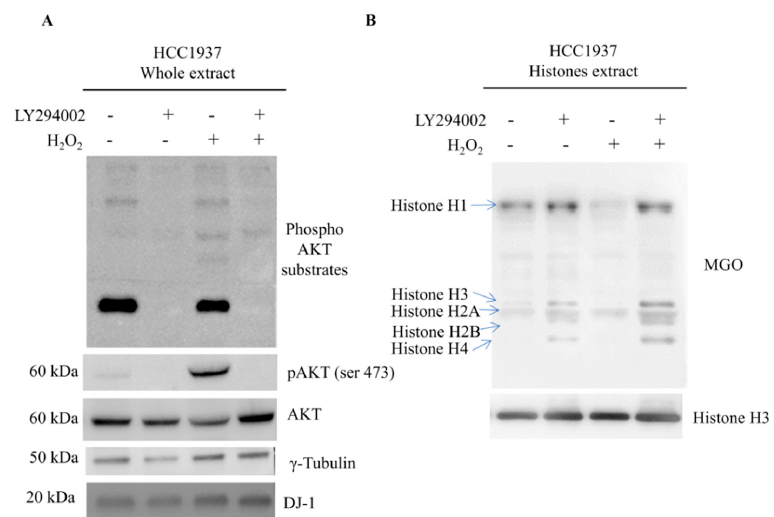
Figure 8. Western blot analysis relative to the expression of Akt activation and AGEs formations in HCC1937 breast cancer cells ( A ) Western blot analysis on whole extract from HCC1937. Levels of Phospho-Akt substrates, Phospho-Akt and DJ-1 are shown in loading control and treated cells. Signals of Phospho antibody were normalized against the total level of Akt. A goat polyclonal anti- γ -Tubulin antibody was used (C-20) to confirm equal loading of whole proteins. Proteins were resolved using Any kD Mini-PROTEAN TGX Precast Protein Gels and blotted using trans-blot turbo system (Bio-Rad). Signals intensities were assessed by densitometry using the Alliance 4.7; ( B ) Western blot analysis on histones extract from HCC1937. Levels of MGO are shown in loading control and treated cells for each histone isoforms resolved on the gel. The major level of MGO are detected on Histone H1. Histones were resolved using 15% Mini-PROTEAN TGX Precast Protein Gels and blotted using trans-blot turbo system (Bio-Rad). Signals intensities were assessed by densitometry using the Alliance 4.7.